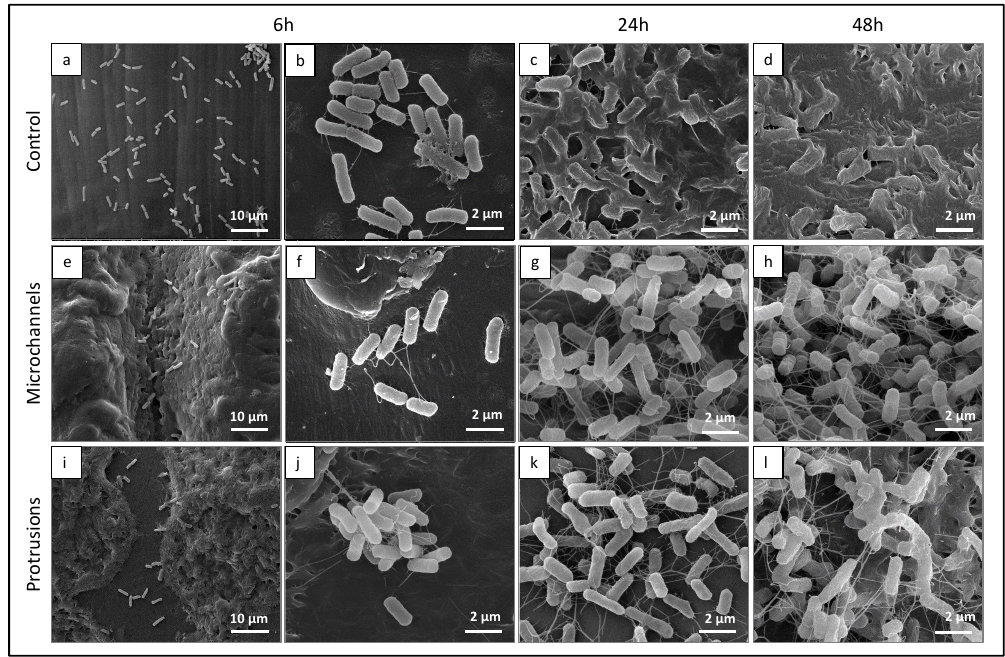
Figure 11. Representative SEM images (6 h, 24 h, and 48 h) of PCL surfaces colonized with E. coli — topographies of the control ( a – d ), laser-induced microchannels ( e – h ), and protrusions ( i – l ). Scale bar: 10 μ m ( a , e , i ), and 2 μ m ( b – d , f – h , j – l ).